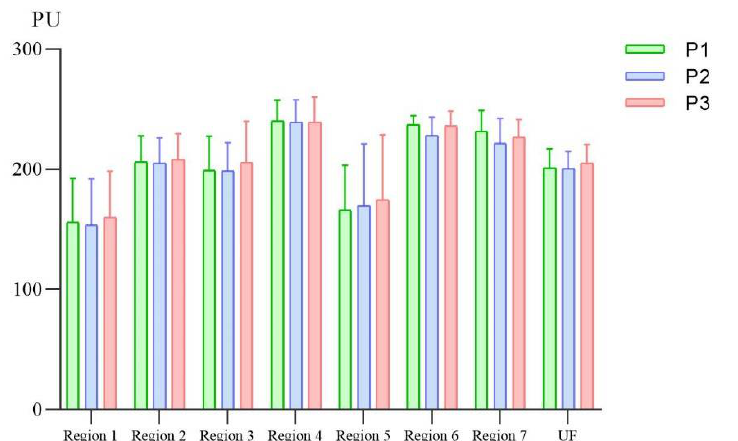
Figure 4. Bar plots of facial skin blood flow of the unaffected face before and after peripheral magnetic stimulation in stroke patients with facial paralysis. P1, 0–5 min before the PMS intervention; P2, 0–5 min after the PMS intervention; P3, 6–10 min after the PMS intervention; UF, the unaffected face; PU, perfusion index.